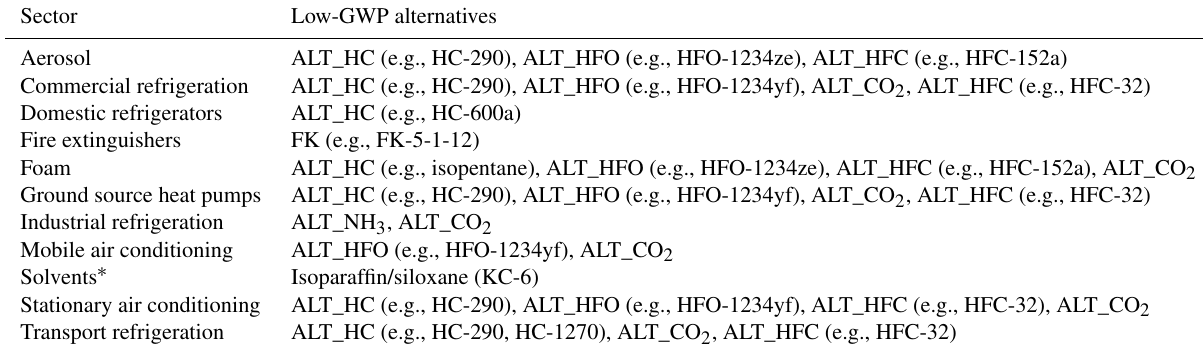
Table 2. Sector specific alternative options for high-GWP HFCs considered in the GAINS model. Sector